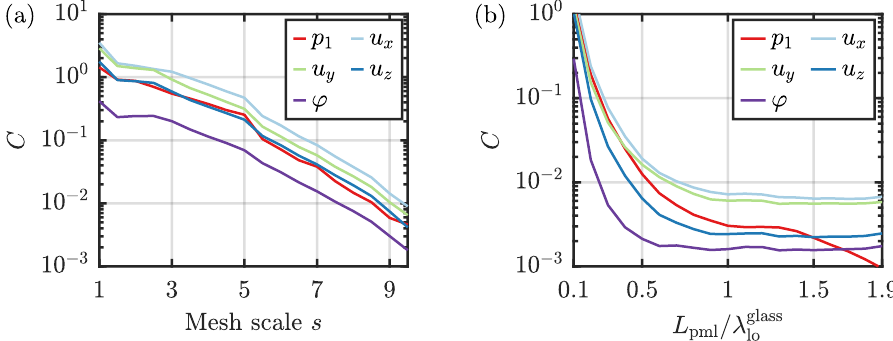
Figure A1. ( a ) Convergence of the pressure field p 1 , displacement field components u x , u y , u z and the electric potential ϕ with increasing mesh scale s . ( b ) Convergence of the pressure field p 1 , displacement field components u x , u y , u z with increasing length of the PML layer L pml , expressed relative to the wavelength in glass λ glass lo